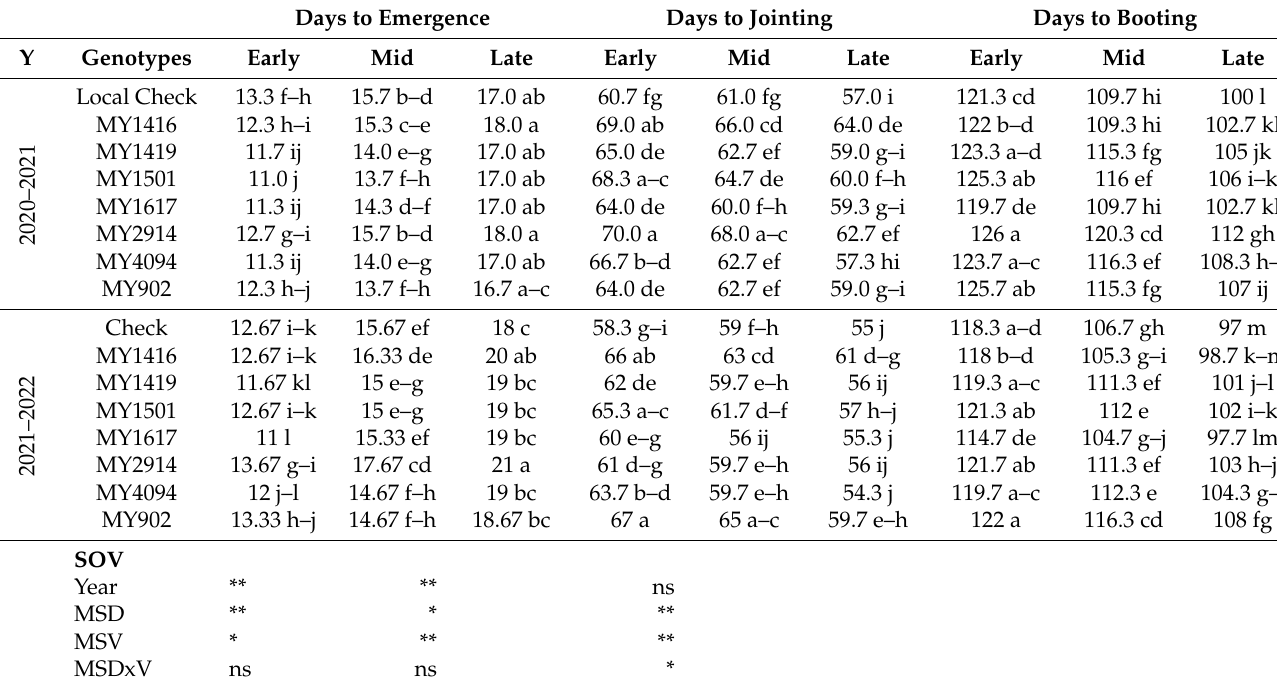
Table 2. Days to emergence, days to jointing, and days to booting of different wheat genotypes grown under the semi-arid climate of northern Pakistan.